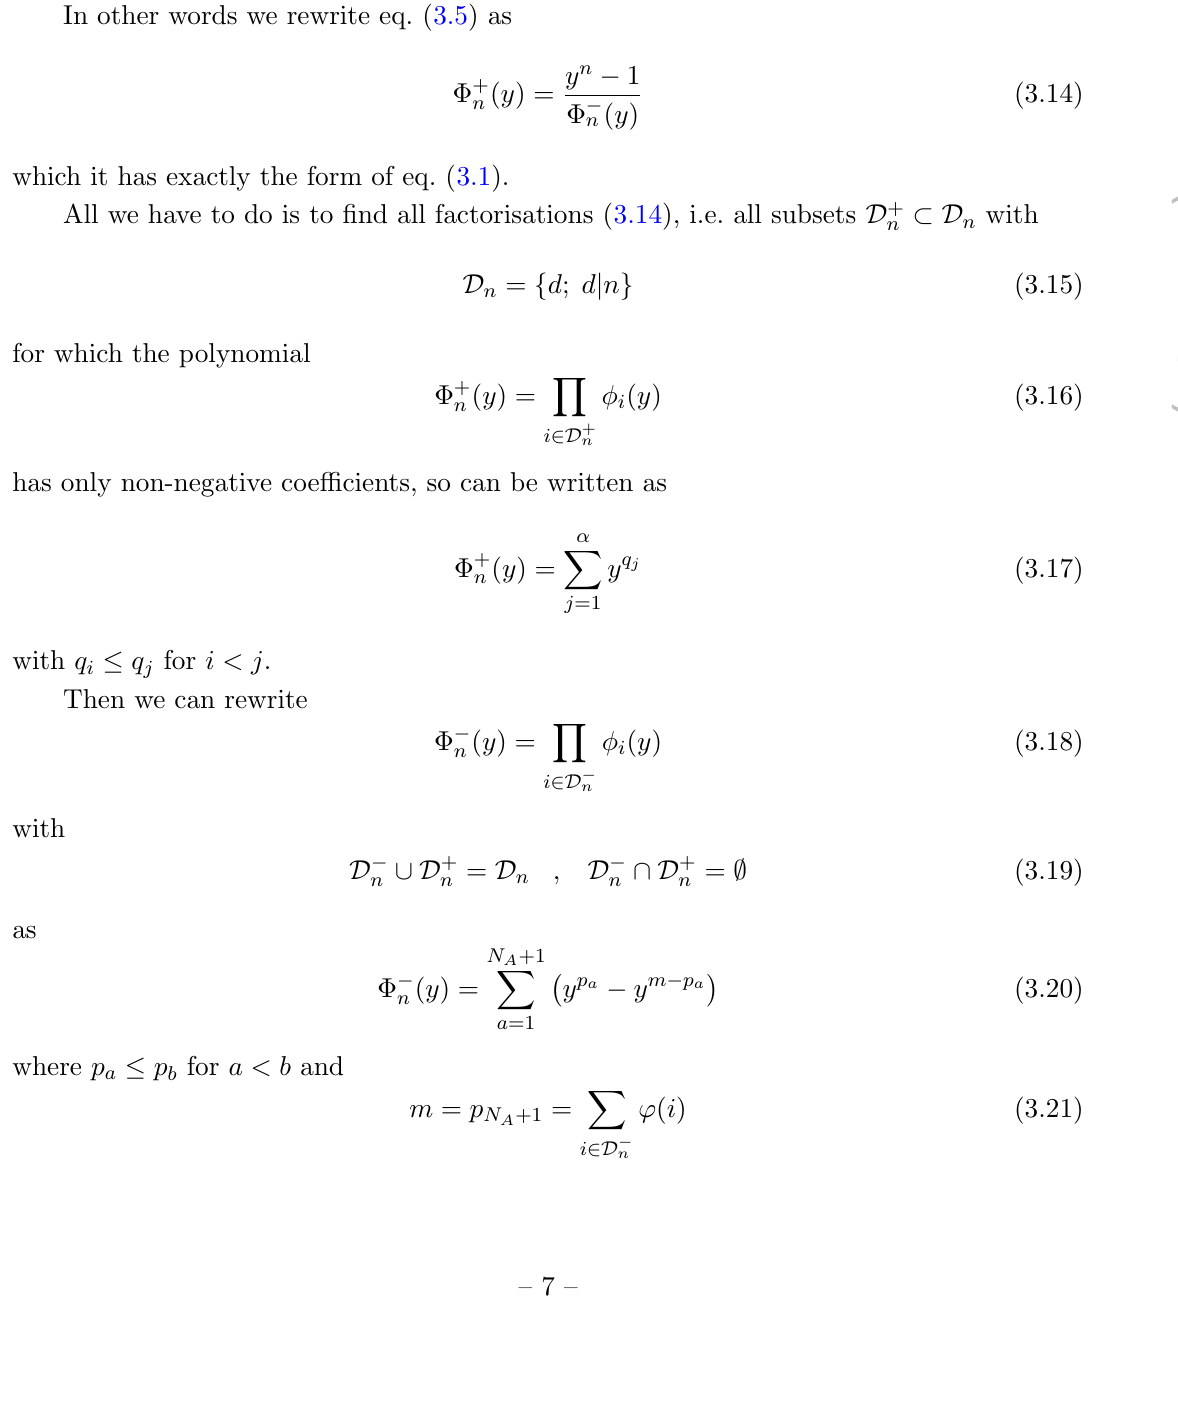
In other words we rewrite eq. (3.5)